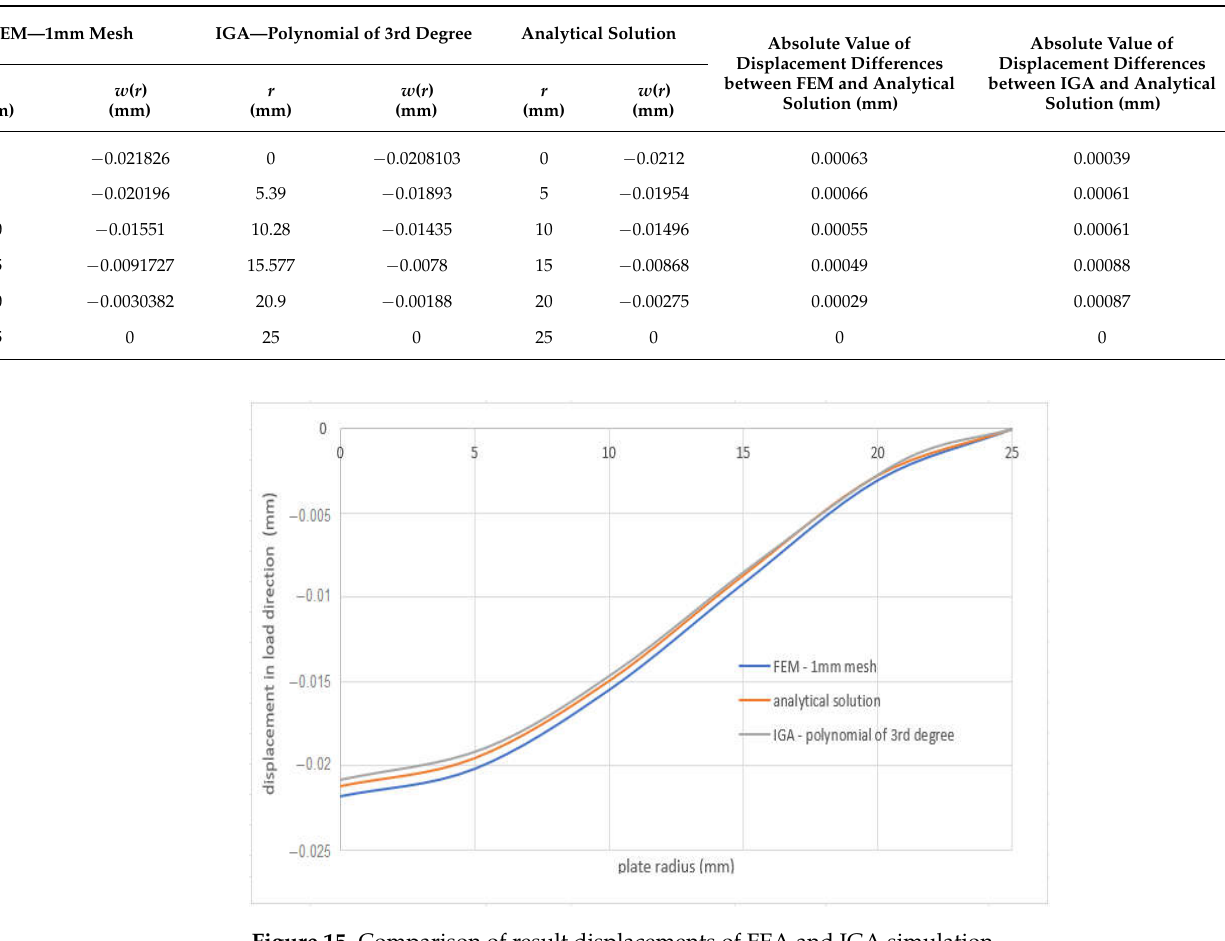
Figure 15. Comparison of result displacements of FEA and IGA simulation.